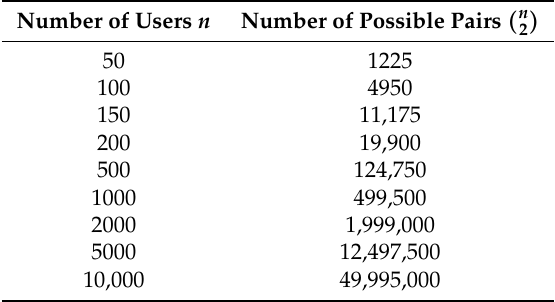
Table 1. Numbers of unordered pairs of users needed to be inspected by brute force